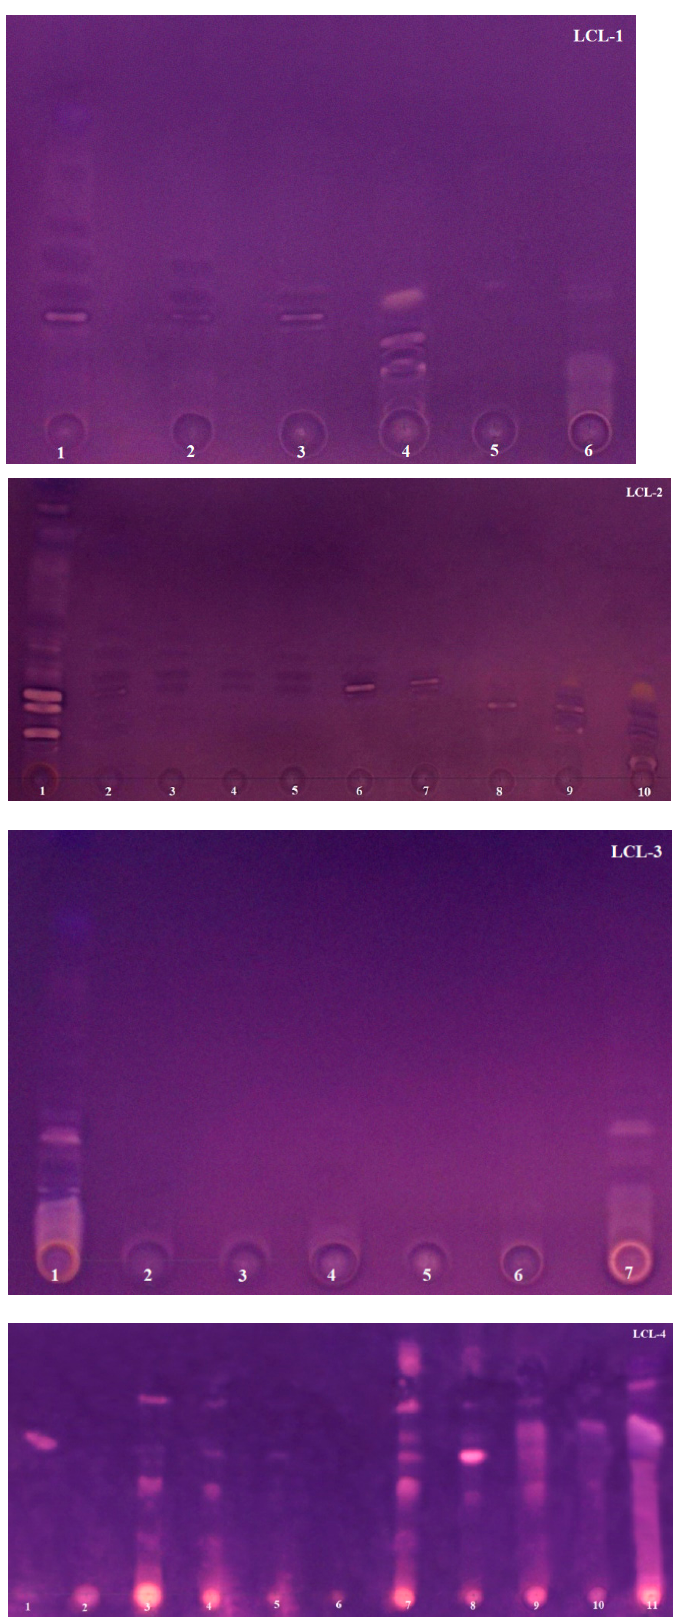
Figure 4. TLC chromatograms presenting L. clavatum fractions obtained from four experiments after acetylcholinesterase assays. LCL ‐ 1 shows 6 fractions obtained from the first experiment via VLC using Al 2 O 3 and silica gel in ratio 1:3 as sorbents; LCL ‐ 2 shows 10 fractions obtained from the second experiment via VLC using Al 2 O 3 and silica gel in ratio 3:1 as sorbents; LCL ‐ 3 shows 7 fractions ob ‐ tained from the third experiment via VLC using silanized silica gel as a sorbent; LCL ‐ 4 shows 11 fractions obtained from the fourth experiment via VLC using silanized silica gel as a sorbent and using new reversed ‐ phase system.